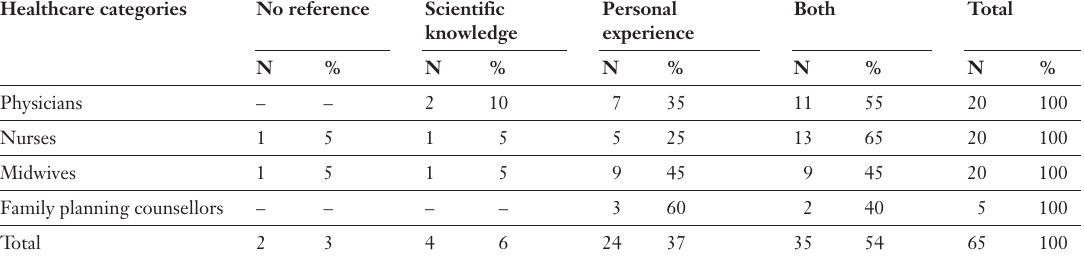
Table 4 Healthcare profes- sional categories: ref- erences to personal experience and scien- tific knowledge (cate- gories are mutually